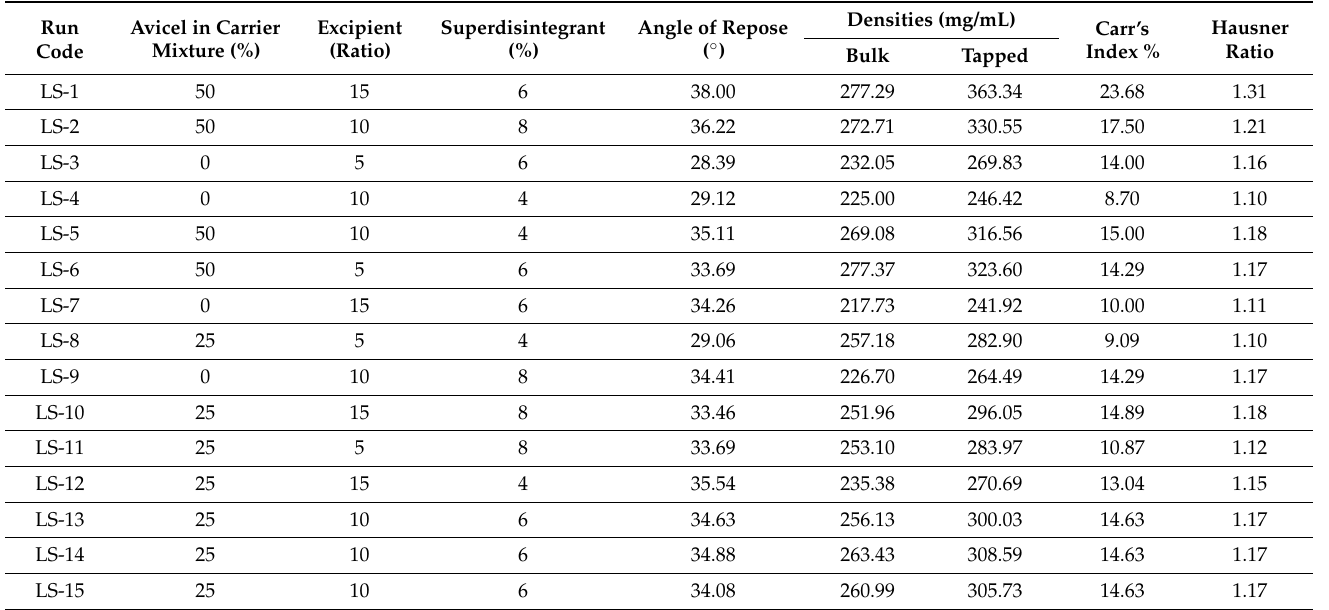
Table 2. Composition of glimepiride liquisolid formulations as suggested by the Box–Behnken design and their pre-compression